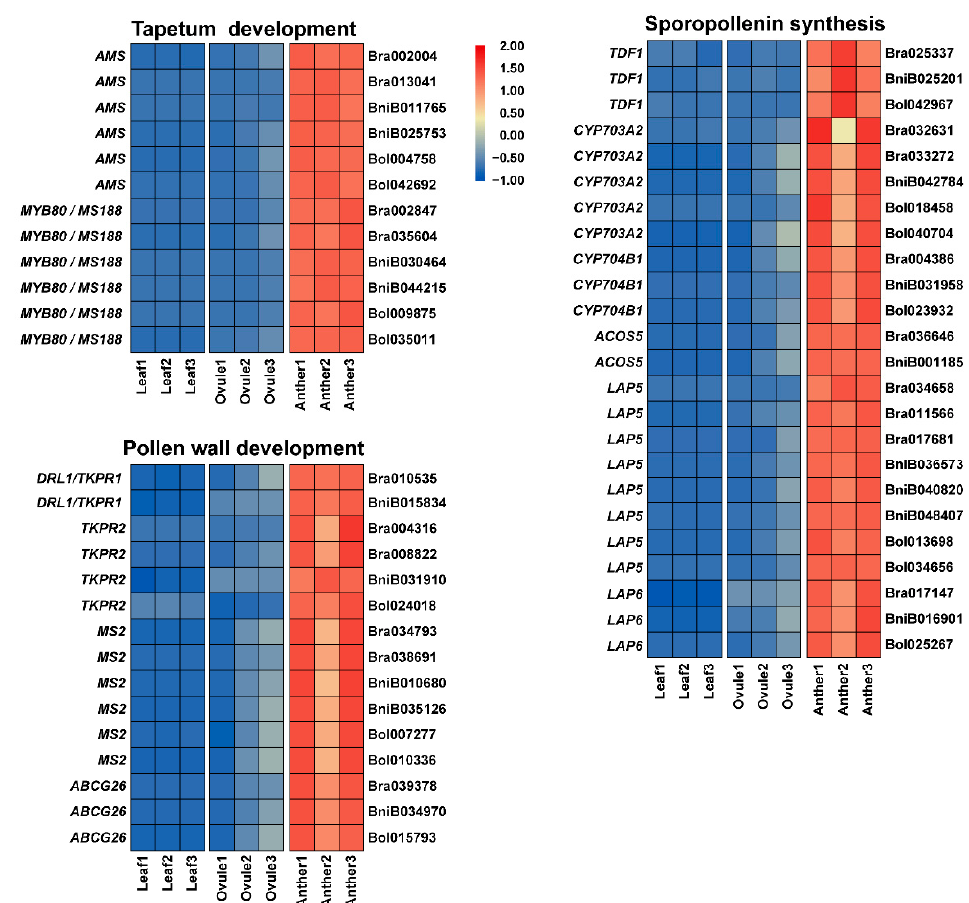
Figure 5. The expression patterns of tapetum development, sporopollenin biosynthesis and pollen wall development related genes in Anther, Ovule and Leaf of Brassica allohexaploids.